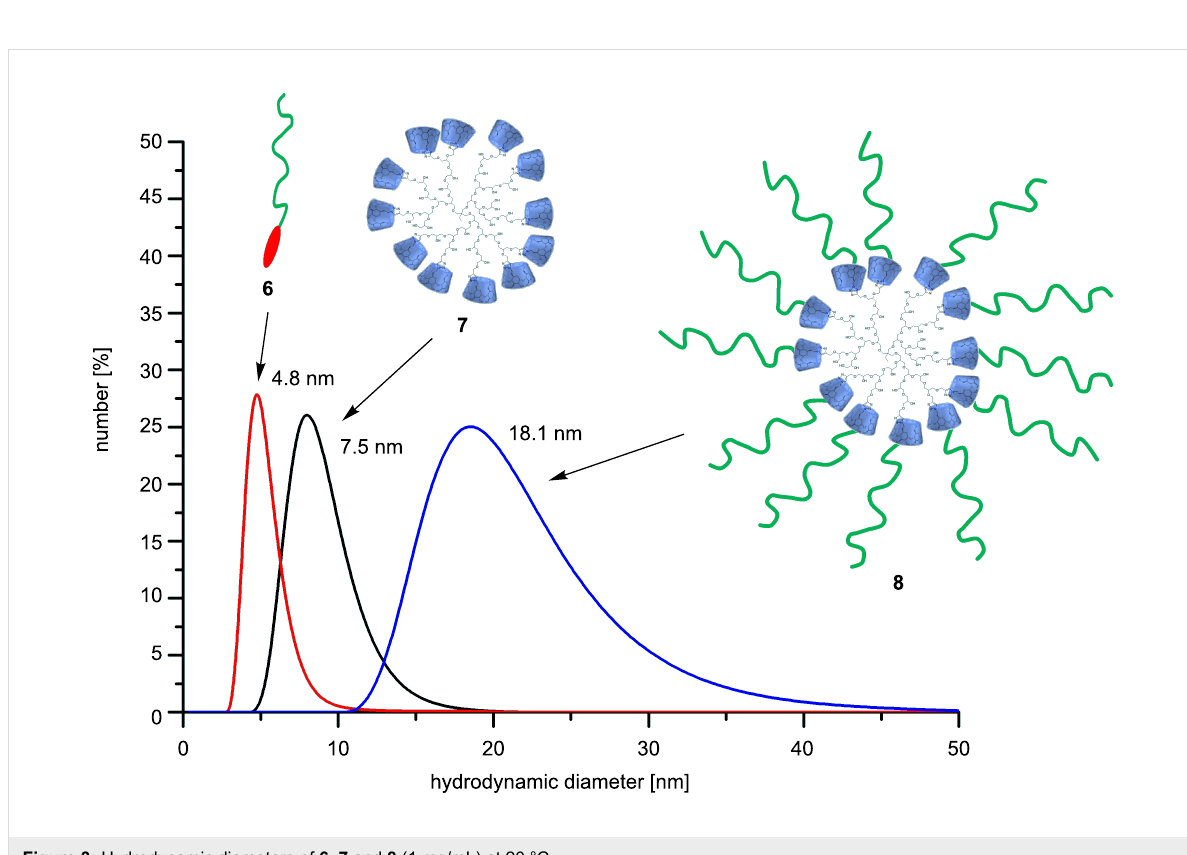
Figure 3: Hydrodynamic diameters of 6 , 7 and 8 (1 mg/mL) at 20